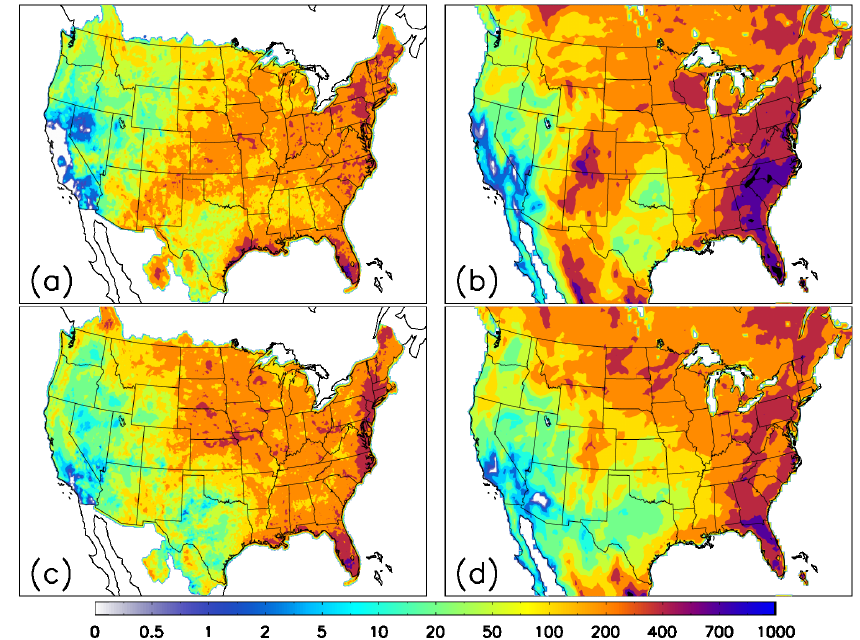
Fig. 2. Spatial distribution of 2006 and 2011 JJA total precipitation in millimeters. (a) and (c) are NWS precipitation degraded to 12km resolution. (b) and (d) are 36km WRF-simulated total precipitation over the same periods with data above water surfaces masked out.